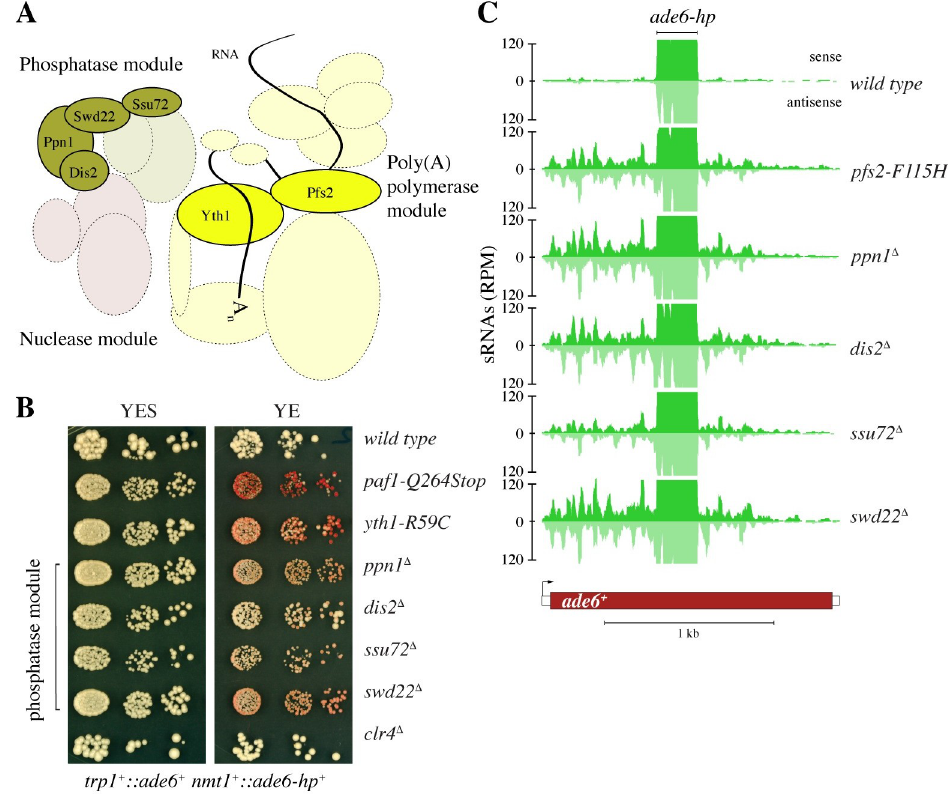
Fig 4. Mutations in the phosphatase module of CPF enable small-RNA-mediated epigenetic gene silencing. (A) Phosphatase, nuclease, and poly(A) polymerase modules of CPF, adapted from a model of budding yeast CPF [29]. Subunits found in this study to enable siRNA-mediated gene silencing when mutated are indicated by filled circles and their protein names. (B) Silencing assay showing the degree of ade6 + silencing in cells with an impaired phosphatase module of CPF. Ssu72 and Dis2 are active phosphatases. See also S4 Fig. (C) Small RNA sequencing was performed with the strains indicated to assess secondary ade6 + siRNA production. Read counts were normalized to library size. The part of ade6 + that is complementary to the primary siRNAs encoded by the ade6-hp is